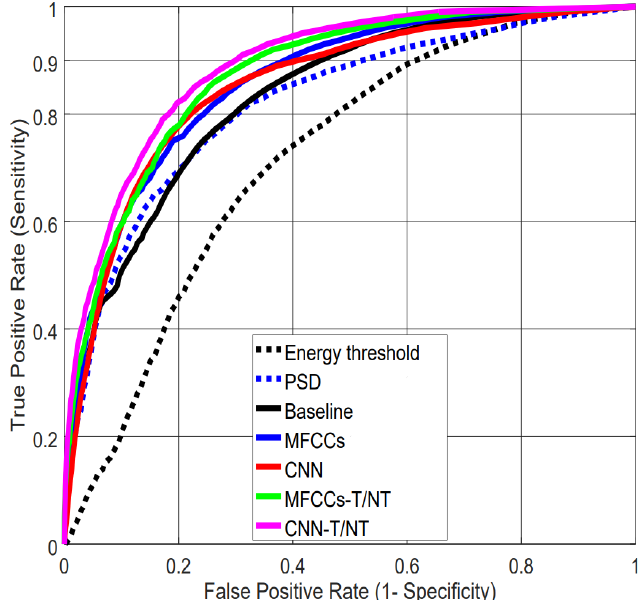
Figure 7. Receiver Operating Characteristic (ROC) curves for the different feature extraction strategies using the MLP classifier. Note: The ROC curve for the “energy in the 3–9 Hz band” feature is computed by sliding the threshold over the range of possible values.